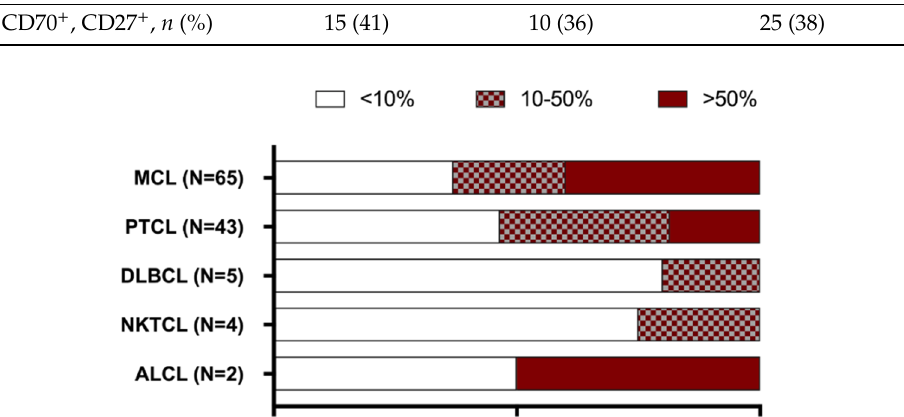
Figure 5. Proportion of CD27 staining among various lymphoma subsets. CD27 staining was categorised in three different groups: CD27 positive tumour cells ranging from 0 to 10% (white bars); between 10 to 50% (patterned bars); and expression levels above 50% (red bars). ALCL, anaplastic large cell lymphoma; DLBCL, diffuse large B cell lymphoma; MCL, mantle cell lymphoma; NKTCL, NK/T cell lymphoma; PTCL, peripheral T-cell lymphoma.